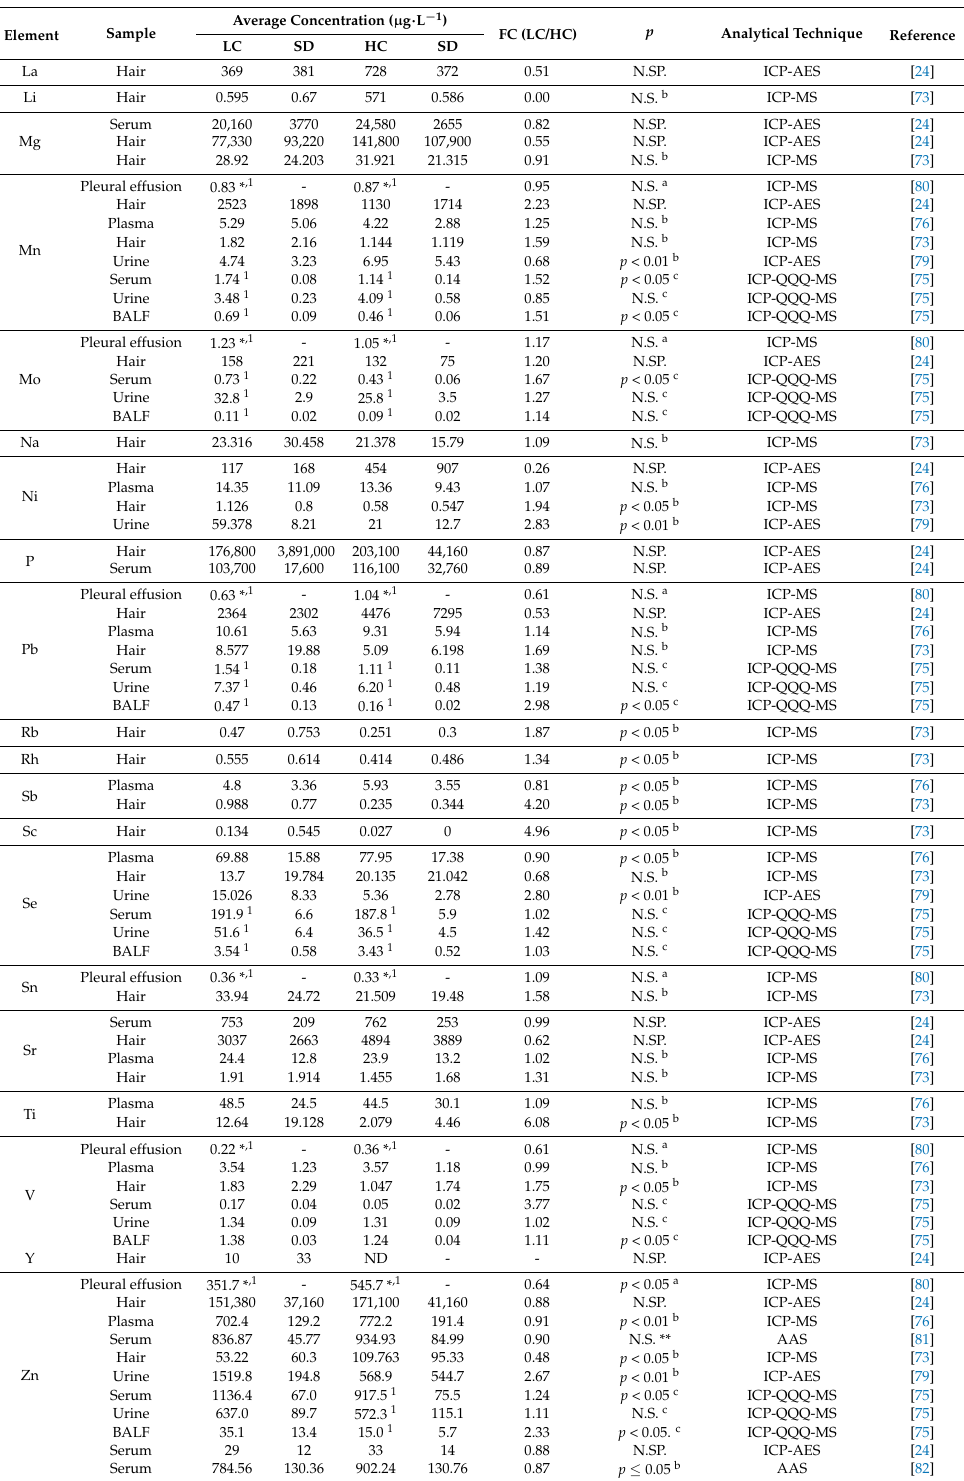
BALF: Bronchoalveolar Lavage Fluid; LC: Lung Cancer; HC: Healthy Control; ND: Not Detected; SD: Standard Deviation; FC: Fold Change. N.S.: Non significant, N.SP.: Not specified. Average Concentration: Arithmetic Mean, Gaussian Distribution, * Data expressed on the median.; 1 : Non-parametric method; a : Kruskal–Wallis test; b : Student T-test; c : Mann–Whitey U-test; ** Statistical test not